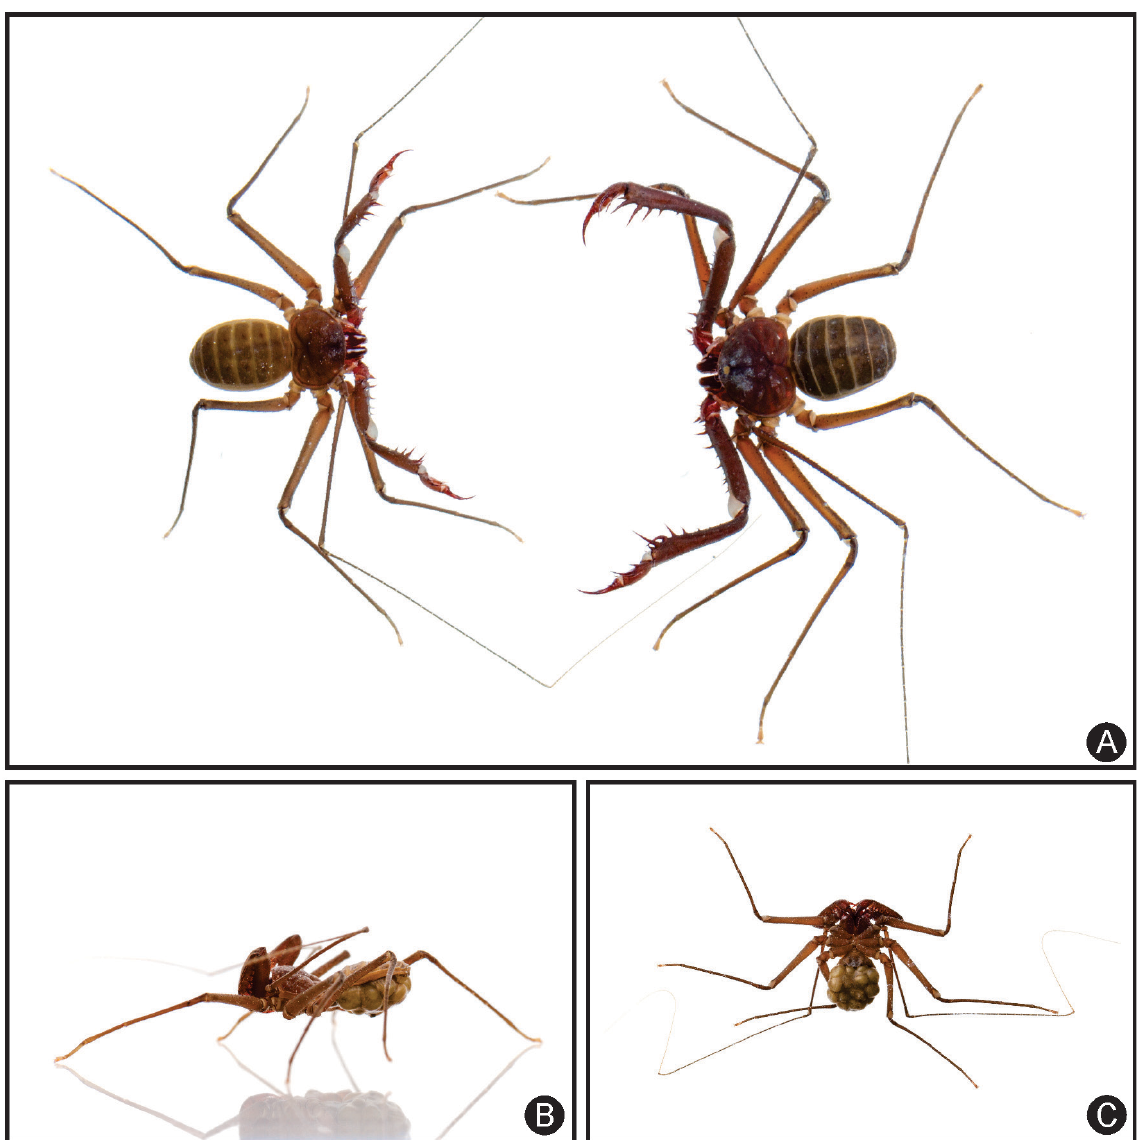
Fig. 5. Live specimens of Charinus israelensis sp. nov. A . Two specimens showing the size range. B . ♀ carrying eggsacs, lateral view. C . ♀ carrying egg sacs, ventral